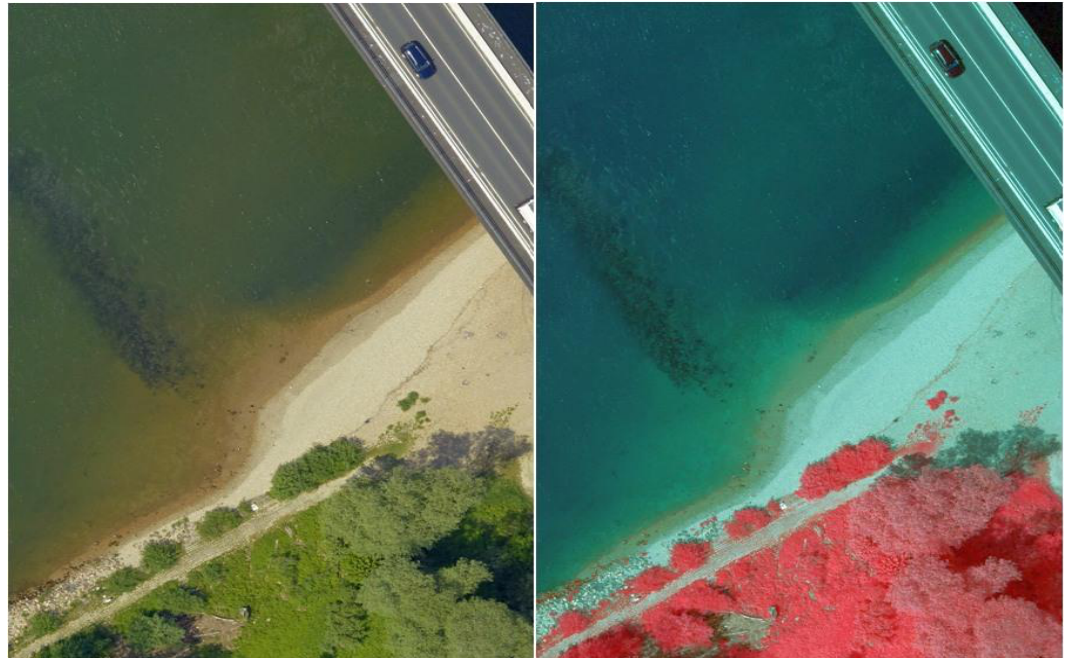
Figure 4. Comparison of True Color and NIR composite. The low chlorophyll content of the water shows there is a higher current which means the area is not a possible breeding ground for